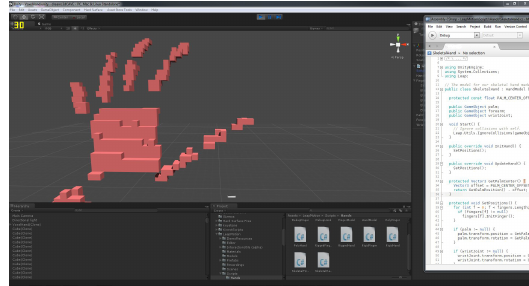
Figure 8. Snapshot of the creation of complex gestures - Evaluation: study of gesture designed to understand which would allow better interaction with the data at a theoretical level, according to usability principles redesigned for the 3D world (understanding of the interaction, ease of use, effectiveness, etc.). - Implementation (fig. 9): implementation of gestures valued as realizable in the virtual environment through dedicated script. A plugin for the game engine was developed, that allows us to change the gesture with a graphical